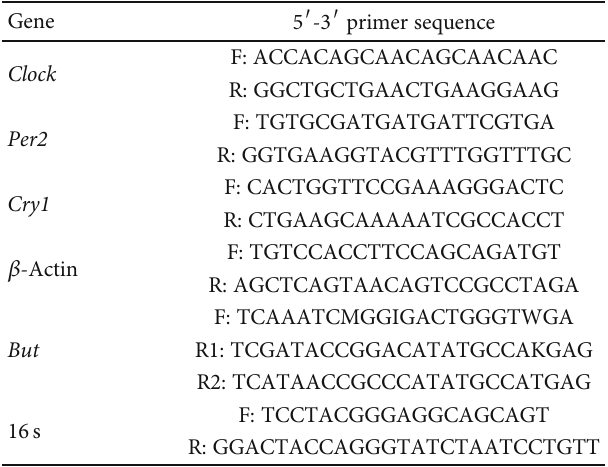
Table 1: Primers for